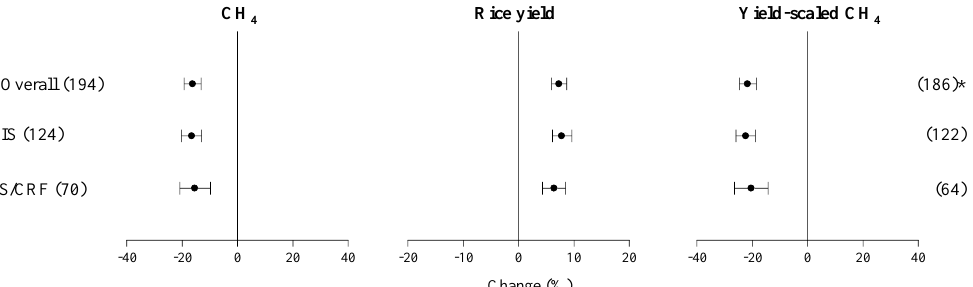
Figure 1. Overall effects of EENF on CH 4 , rice yield, and yield-scaled CH 4 emission from rice fields. * the number of comparisons for rice yield and yield-scaled CH 4 , which is less than that for CH 4 , because 4 studies did not report rice yield. All error bars represented 95% confidence intervals.